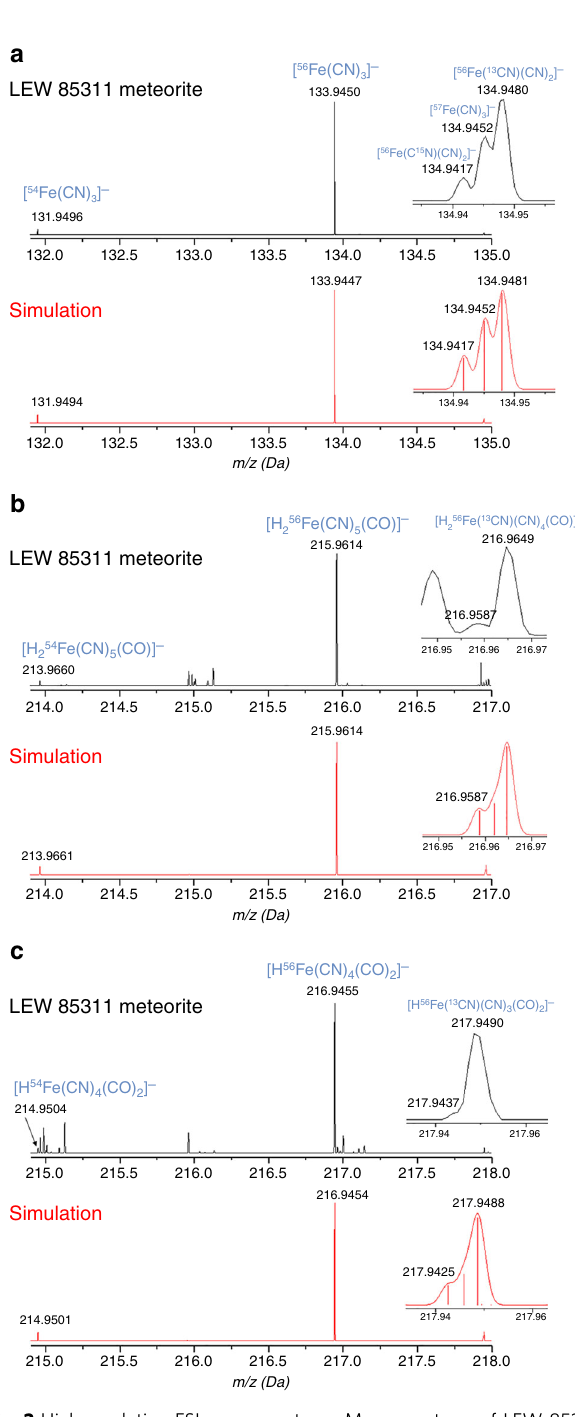
Fig. 2 High resolution ESI mass spectra. a Mass spectrum of LEW 85311 meteorite extract along with simulated isotope pattern of [Fe II (CN) 3 ] − . b Mass spectrum of LEW 85311 meteorite extract along with simulated isotope pattern of [H 2 Fe II (CN) 5 (CO)] − . c Mass spectrum of LEW 85311 meteorite extract along with simulated isotope pattern of [HFe II (CN) 4 (CO) 2 ] − . Accurate mass measurements and isotope patterns support the identi fi cation of two iron cyanocarbonyl complexes and a shared fragment ion. H + serves as counterions which reduce the overall charge of these species to − 1. Simulated isotope patterns (in red) were generated using a Gaussian pro fi le and a mass resolution of 65,000 resolution (full-width at half-maximum) in the Thermo Scienti fi c XCalibur